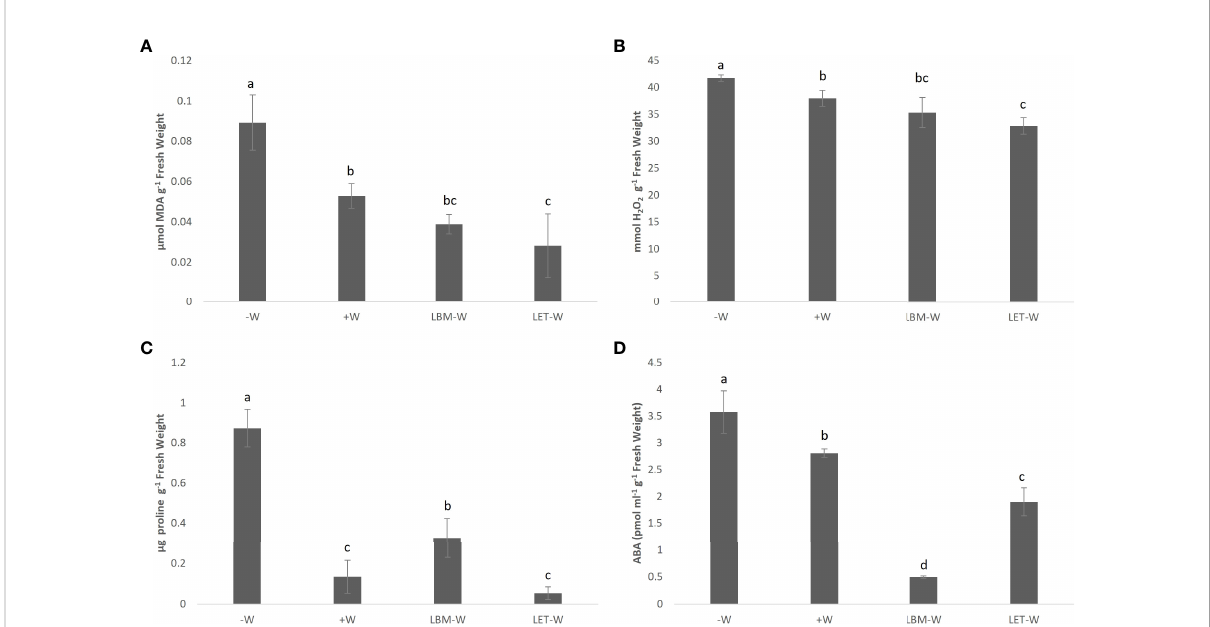
FIGURE 3 Effect of rhizobia strains LBM and LET inoculations on (A) MDA, (B) H 2 O 2 (C) proline, and (D) ABA content of wheat plants under water-stress conditions (LBM-W and LET-W). Water-stress/non-inoculated wheat plants (-W) and non-water stress/non-inoculated plants (+W). Controls were included in the analysis. Mean values and standard deviation of three replicates. Tukey ’ s test was used to compare mean values; means followed by the same letter did not signi fi cantly differ at p ≤ 0.05.